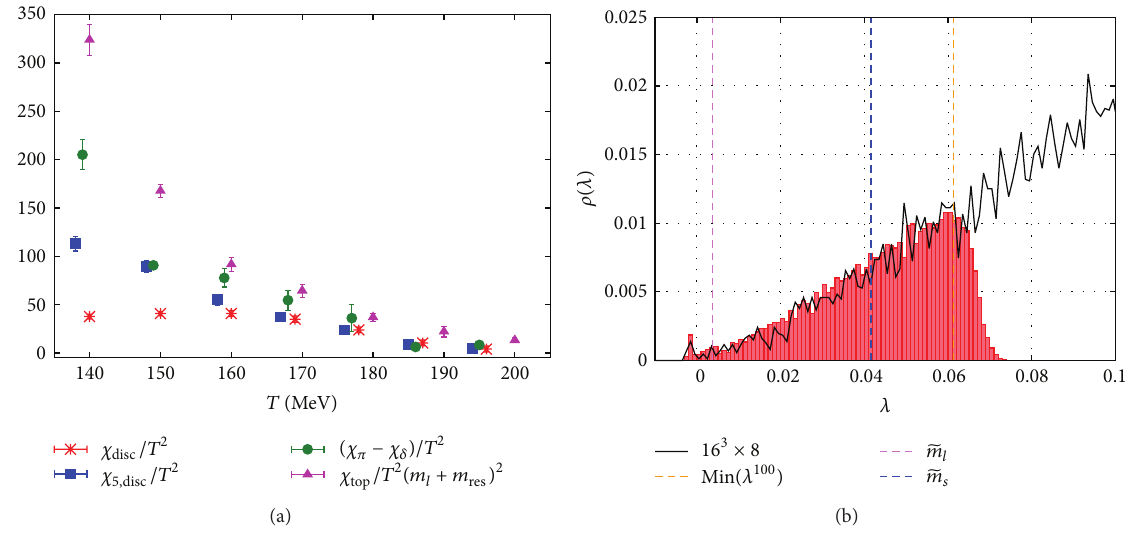
Figure 11: The susceptibilities for different meson quantum states constructed with the domain wall fermions are shown as a function of temperature in (a), from [61]. The eigenvalue distribution with domain wall fermions, shown in (b), from [73], has a peak in the near zero mode distribution at 177 MeV. The lattice size is 16 3 × 8 × 𝑁 5 where 𝑁 5 = 32 for 𝑇 ≥ 160 MeV and 𝑁 5 = 48 otherwise.